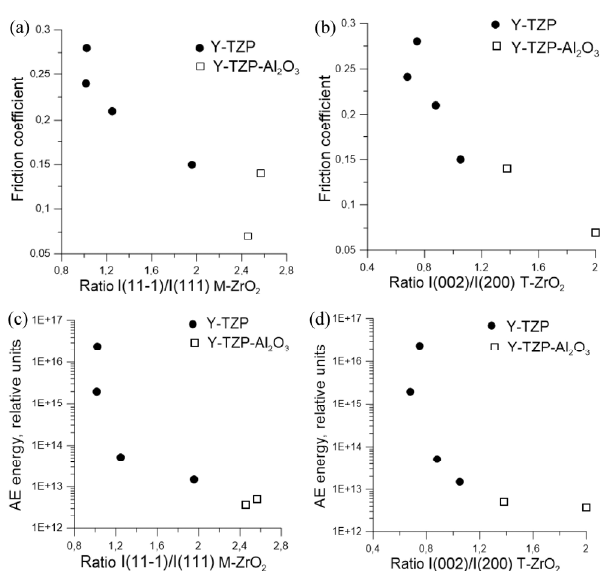
Fig. 11 Monoclinic-phase peak I 002 /I 200 (a) and tetragonal I 11-1 /I 111 (b) peak intensity dependencies of friction coefficient and AE energy ((c) and